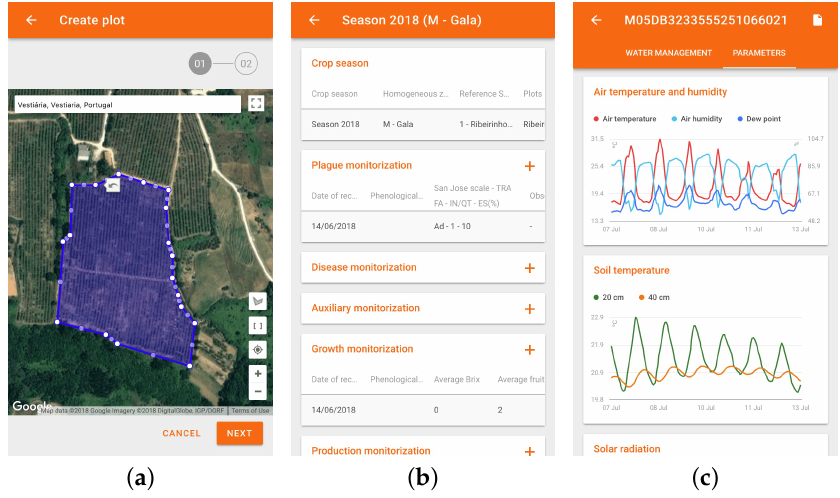
Figure 38. Agroop Cooperation: ( a ) Create and manage various land and/or parcels; ( b ) Manage and monitor crops; ( c ) Analysis of data from the Stoock device.